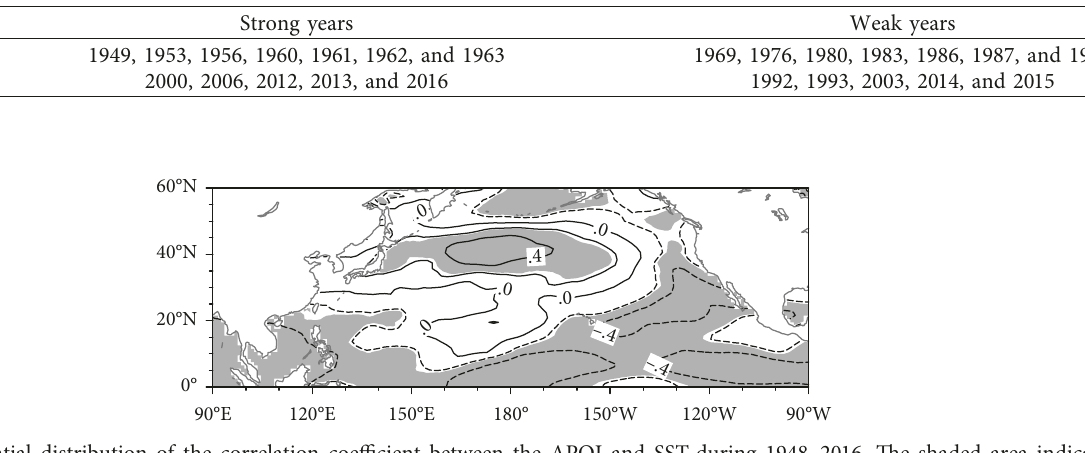
Table 1: Strong and weak APO years in two periods.